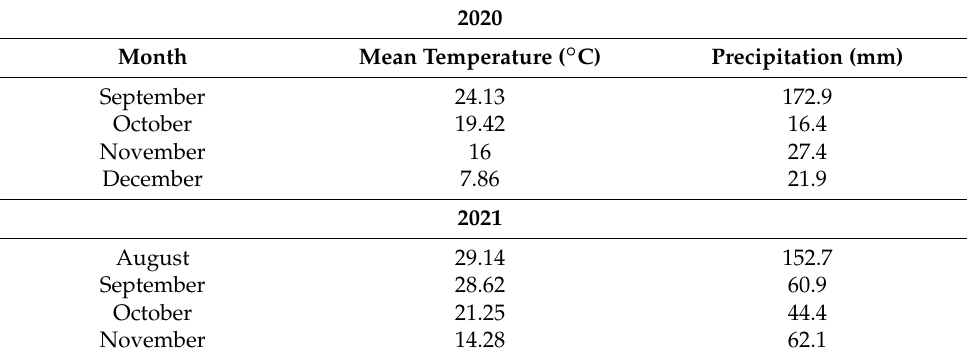
Table 1. The start time of the test was adjusted according to the climate of the year, and 2021 started earlier than 2020. Table 1. Monthly meteorological data during the broccoli growth periods in 2020 and